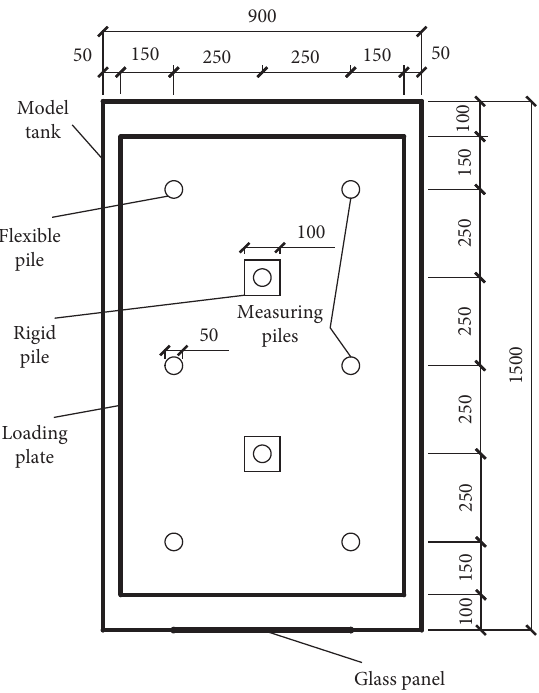
Figure 3: Horizontal layout of the model test (unit: mm).